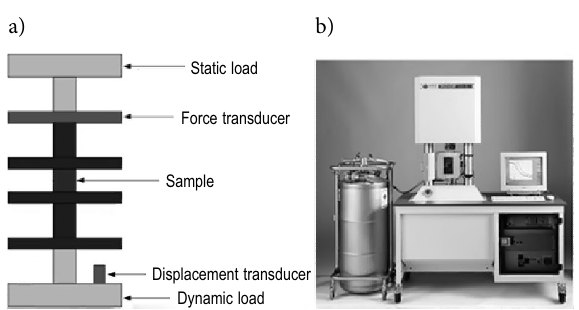
Fig. 4. EPLEXOR ® 500 machine: scheme (a) and picture